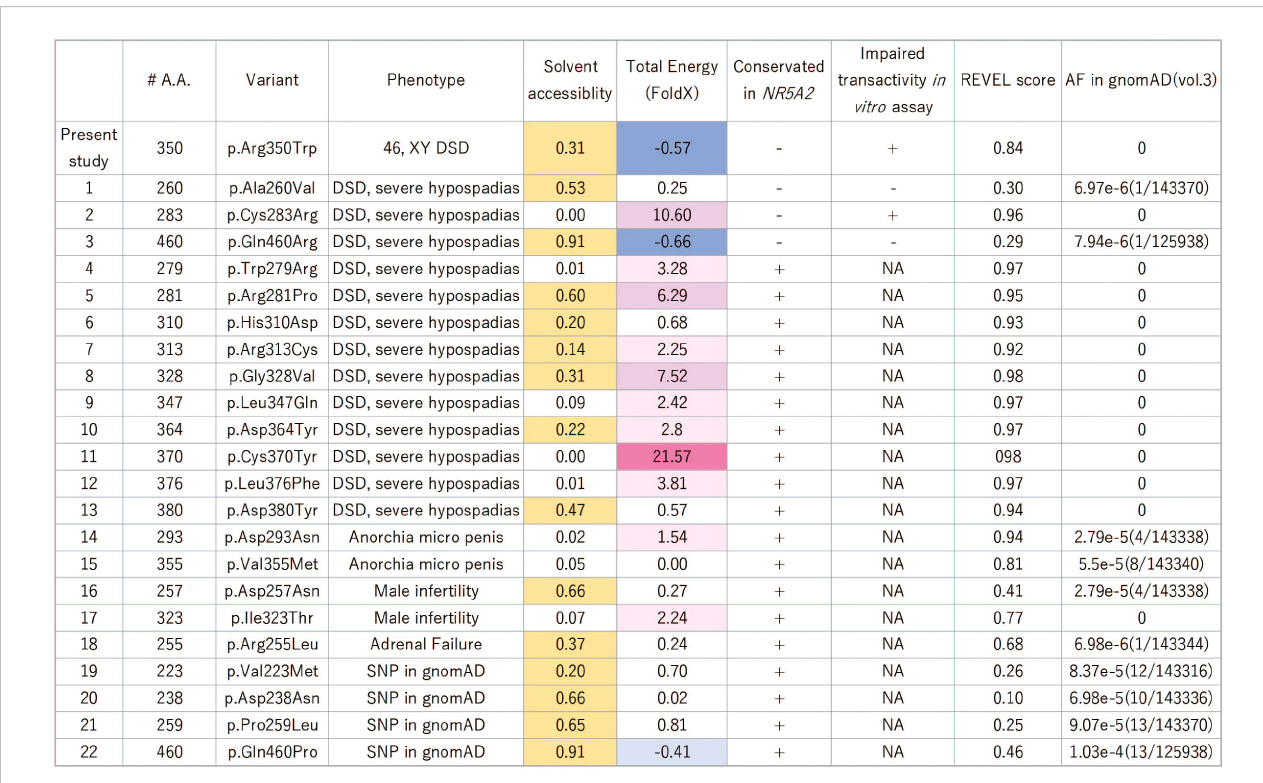
FIGURE 2 Summary of the reported missense variants on the NR5A1 LBD. Yellow colored amino acids are predicted to be located outside surface. In the LBD of NR5A1, 22 missense variants have been identi fi ed in patients with 46,XY DSD to date. Of these 22 amino acid residues, 19 were conserved in NR5A2, and only three, p.A260V, p.C283R, and p.Q460R, were not conserved. The functional analyses showed that p.A260V and p.Q460R were not deleterious variants. The thermal stability analysis (FoldX), indicated that p.R350W would not destabilize LBD structure while p. C283R variant would. The speci fi city of the REVEL score at 0.5 and 0.75 for pathogenic are 89.1% and 95%, respectively (31). DSD, Disorder of Sex Development; NA, not